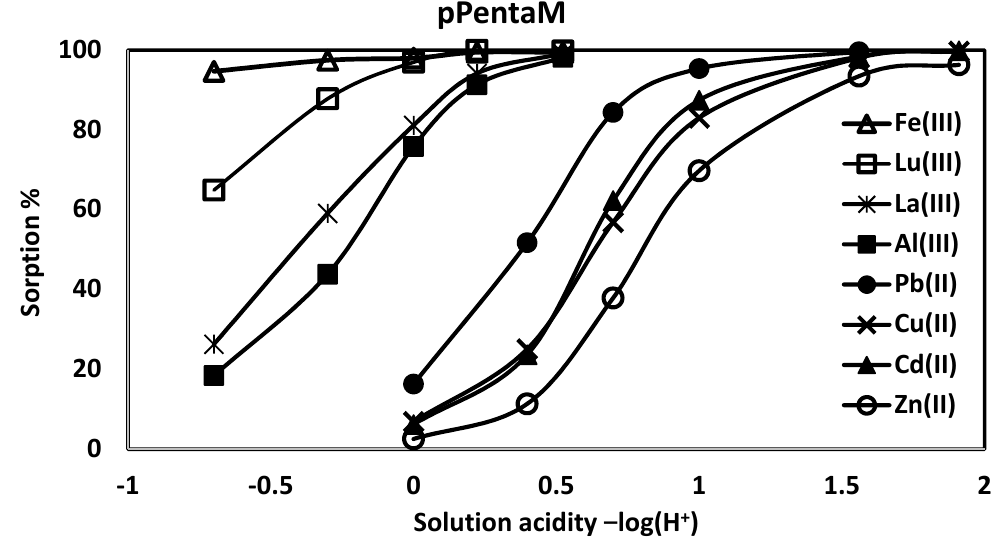
Figure 3. Divalent and trivalent metal ion affinities for pPentaM.